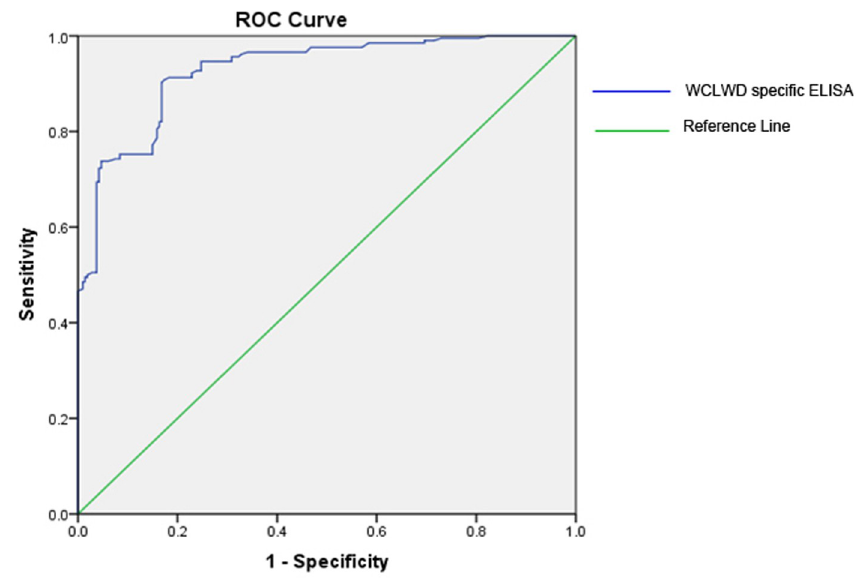
Fig 2. Receiver operating characteristic (ROC) curve analysis of the in house developed indirect ELISA to discriminate phytoplasma s ecA PCR positive coconut samples symptomatic for WCLWD from symptomless, apparently healthy coconut samples.